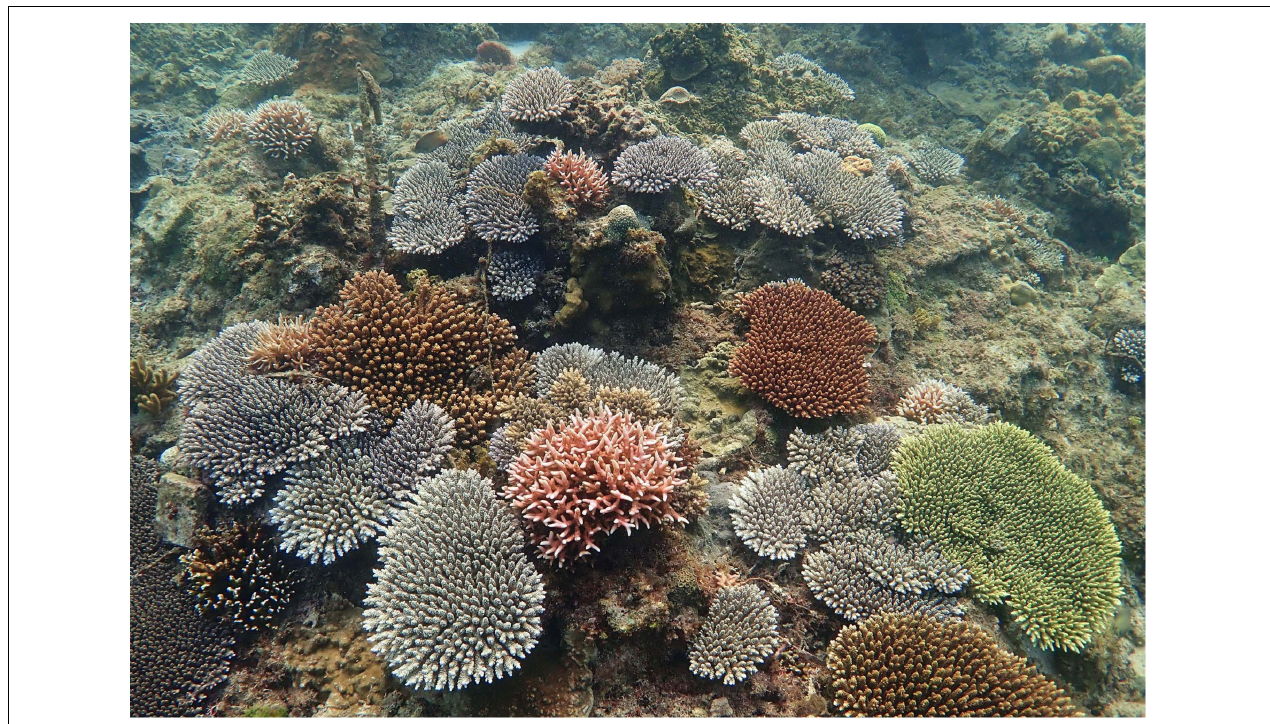
FIGURE 6 | High densities of A. tenuis colonies growing on a larval enhancement plot 34 months after larval settlement.